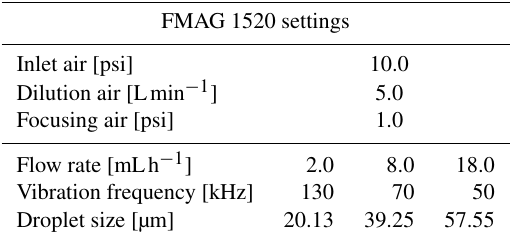
Table 5. Settings of the FMAG droplet generator used during sizing